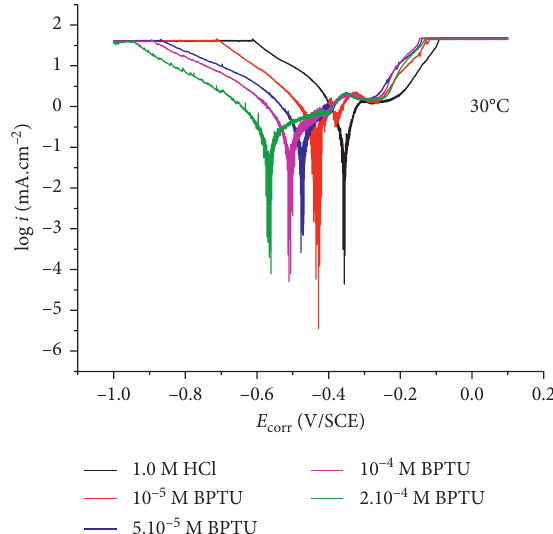
Figure 6: Potentiodynamic polarization curves of mild steel in 1.0M HCl with different concentrations of BPTU at 30 ° C. Table 2: Polarization curve parameters of low carbon steel in 1.0 M HCl with different concentrations of BPTU and URO at 30 ° C. Inhibitors Concentration (M) BPTU URO ∗ Values in parenthesis in the last column of this table are the mean absolute